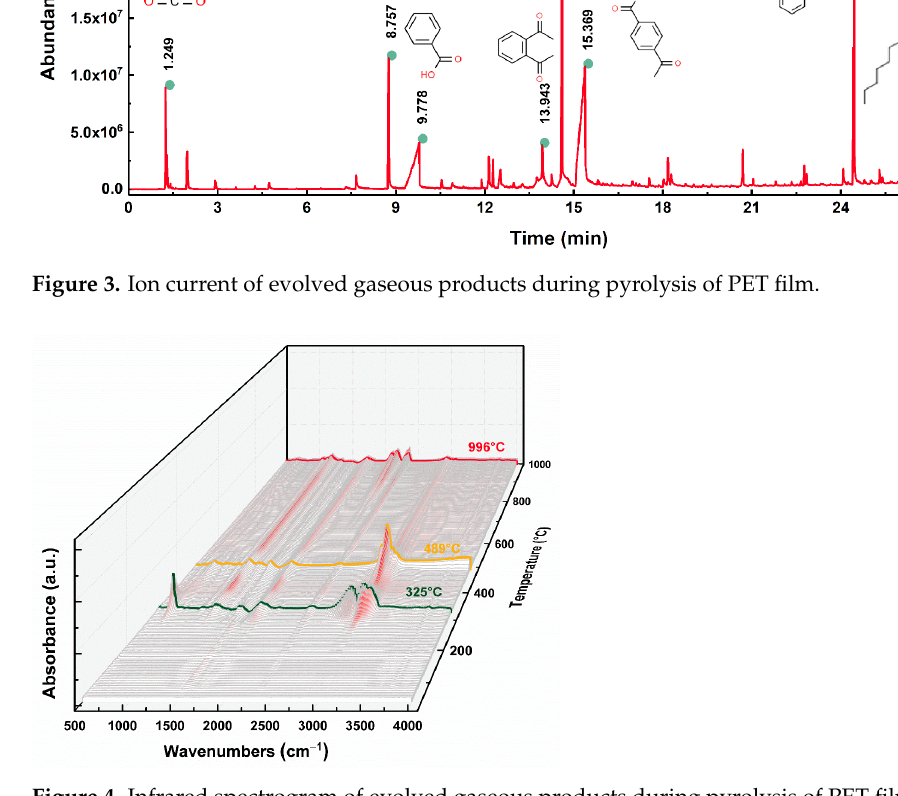
Figure 4. Infrared spectrogram of evolved gaseous products during pyrolysis of PET film.